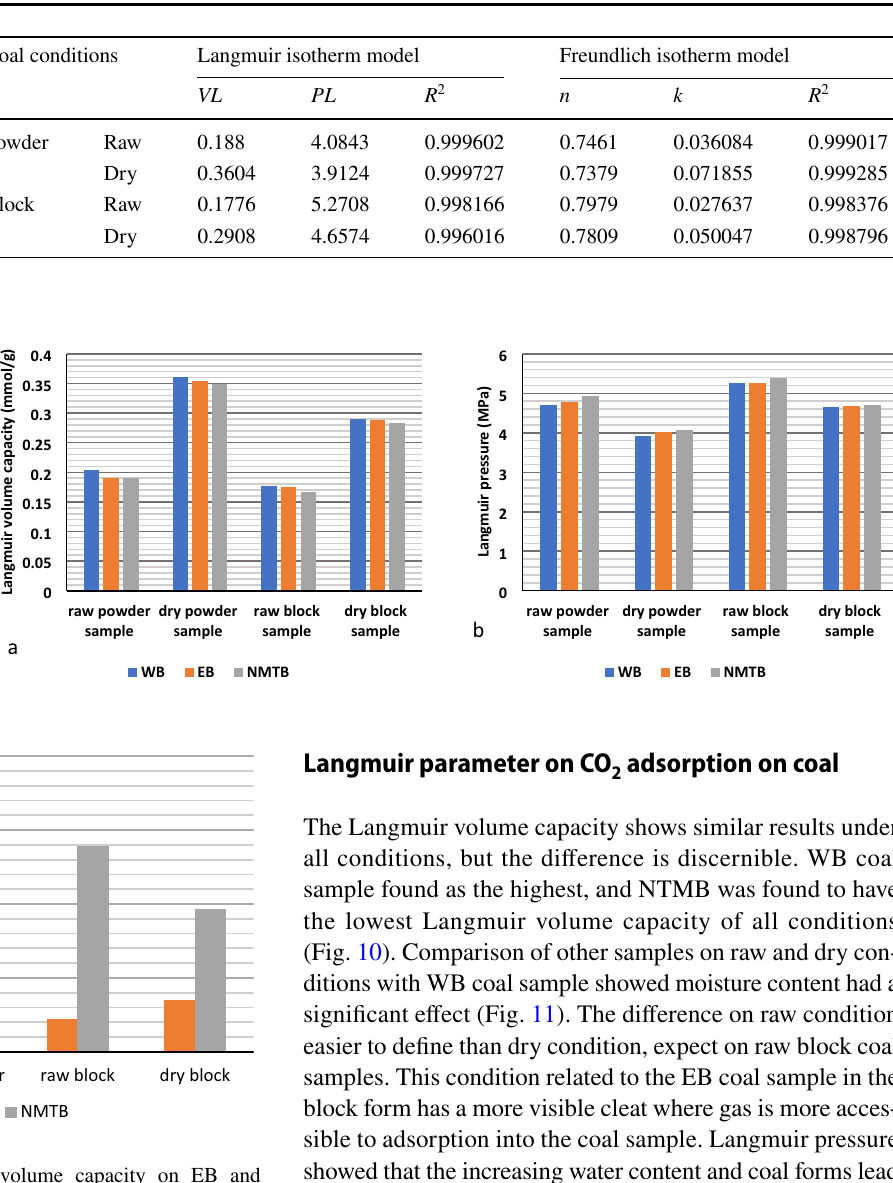
Fig. 11 The difference in Langmuir volume capacity on EB and NMTB from WB coal